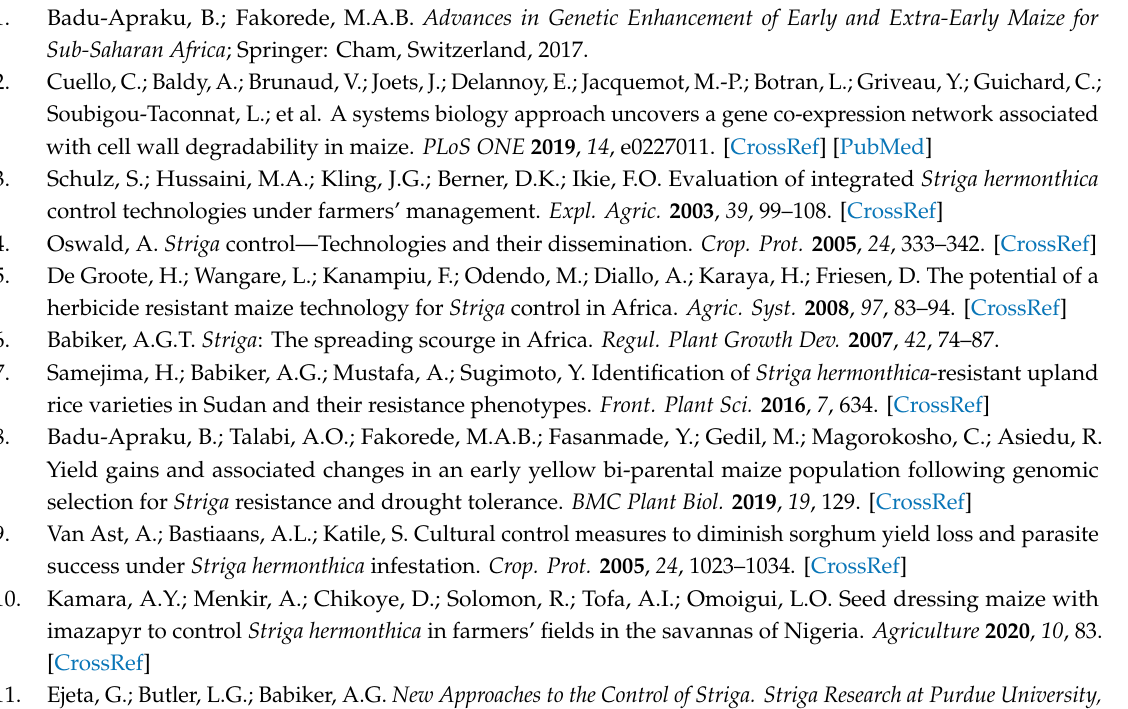
Table S1: Mean squares of F 2:3 mapping population evaluated under artificial Striga infestation at both Abuja and Mokwa in 2018 growing season. Table S2: Shapiro-Wilk’s normality tests for Striga resistance / tolerance indicator traits for F 2 : 3 population derived from the cross between TZEEI 79 ( Striga resistant) and TZdEEI 11 ( Striga susceptible). Table S3: Candidate genes associated with the identified QTL for key Striga resistance / tolerance indicator traits under artificial Striga infestation. Figure S1: Linkage map of F 2:3 mapping population based on 1139 DArTseq markers. Left bar of the linkage map indicates cM distance while right bar of linkage map displayed the marker names. Red bars and letters indicate QTL identified across Striga infested environments. Figure S2. Major QTL identified for Striga resistance in the extra-early yellow mapping population. A likelihood of odds (LOD) scan showing the QTL identified on chromosomes 1, 2, and 8 explaining ≥ 10% phenotypic